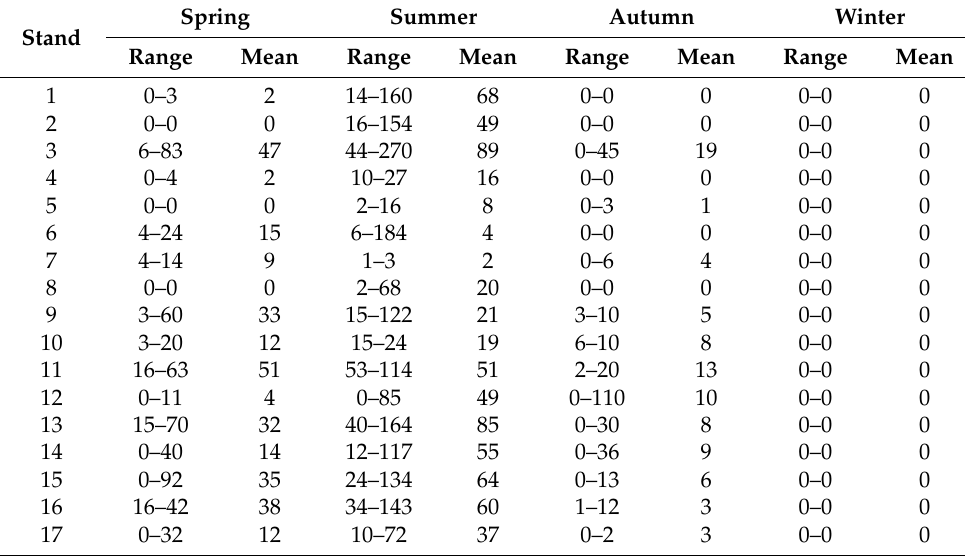
Table 1. Numbers (cfu g − 1 dry soil) of Salmonella spp. within soil sampled in the municipal waste landfill area during studied